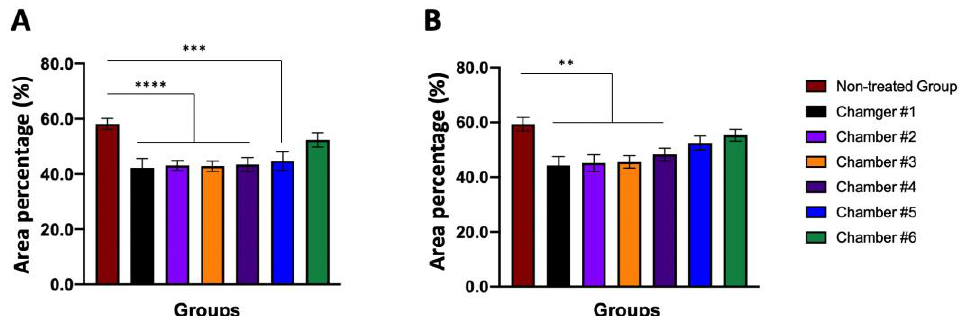
Figure 5. Graph showing the space of the alveolar sac lumen within the lung lobe. The area ratio of the space where gas exchange can occur per unit area is shown. ( A ) When comparing results in males, each concentration in Chamber #1 – Chamber #5 shows a significant difference for ClO 2 gas compared to the non-treated group. ( B ) When comparing results in females, each concentration in Chamber #1 – Chamber #4 resulted in a significant difference for ClO 2 gas compared to the non-treated group. **, p < 0.005; ***, p < 0.0005; ****, p < 0.0001. Error bars represent mean ± SEM.